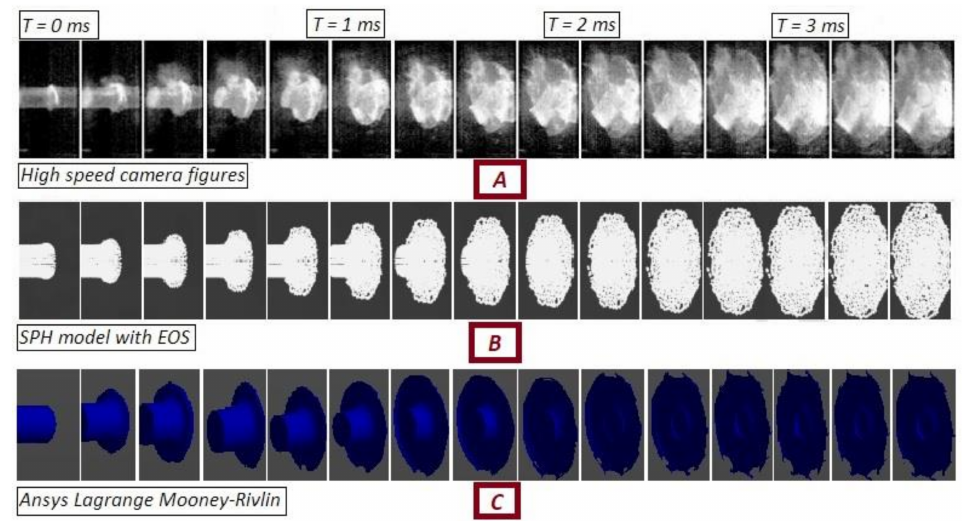
Figure 7. Radial spread of bird model. ( A ) Experimental observation. Reprinted with permission from Ref. [38]. 2019, Zhou et al.; ( B ) SPH model. Reprinted with permission from Ref. [38]. 2019, Zhou et al.; ( C ) Current Lagrange